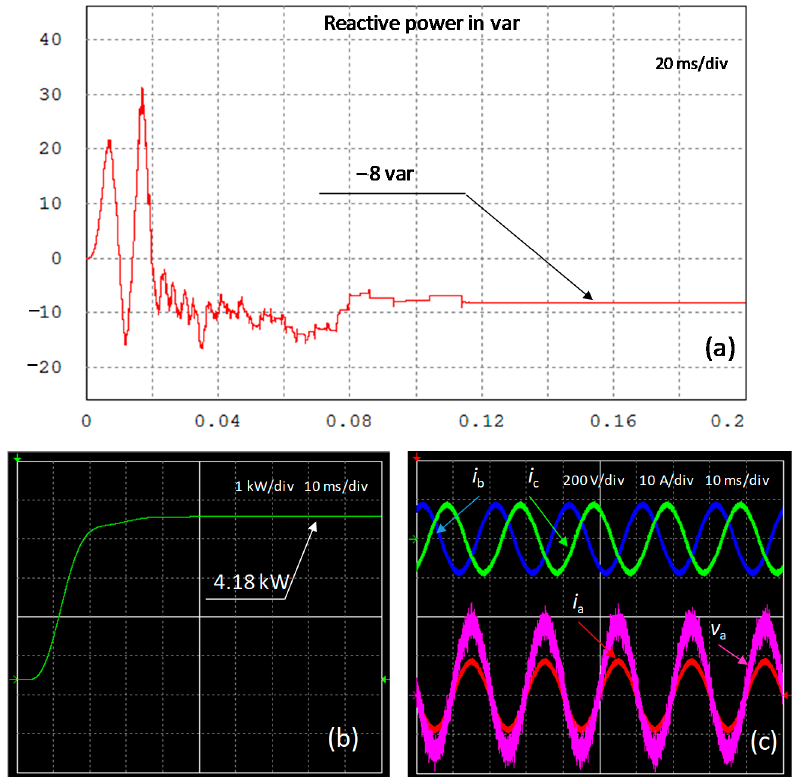
Figure 8. Registered data for reference active current I α ref = 10 A and reference reactive current I β ref = 0 A: reactive power in var ( a ); active power in W ( b ); grid currents and voltage waveforms ( c ).